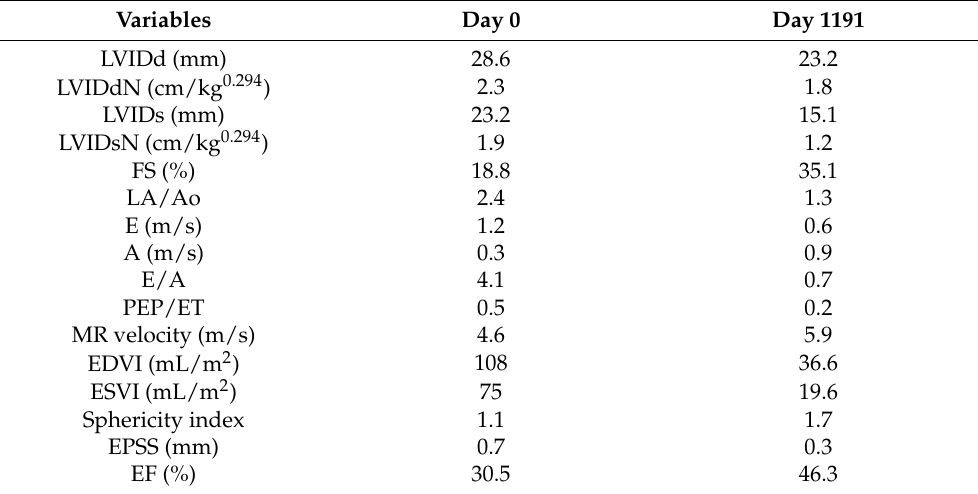
Table 1. Changes in conventional 2D and Doppler examinations on day 0 and day